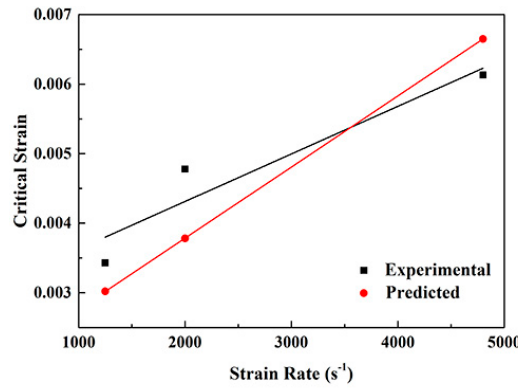
Figure 9. Comparison between predicted and experimental results of critical strain.